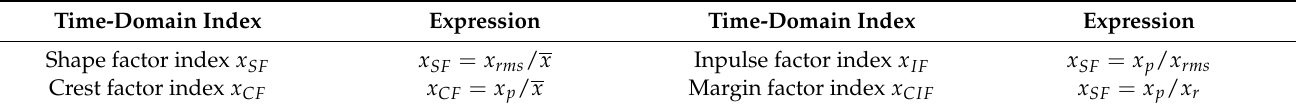
Table 2. Dimensionless time-domain